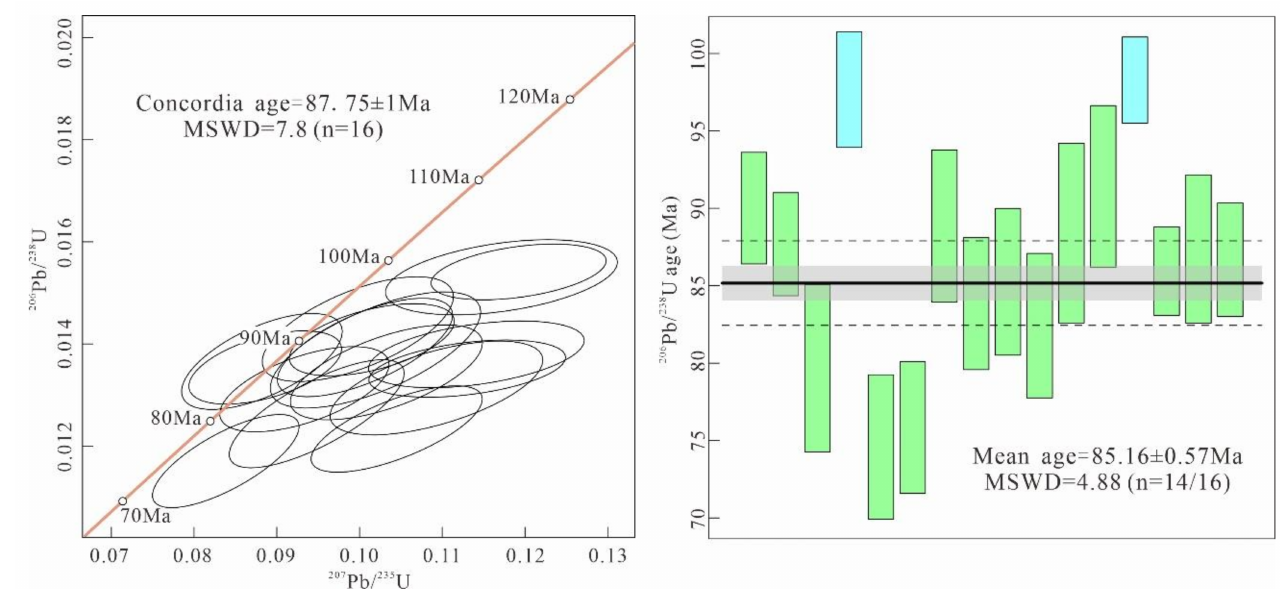
Figure 5. LA-ICP-MS zircon U–Pb Concordia age and weighted mean age of the